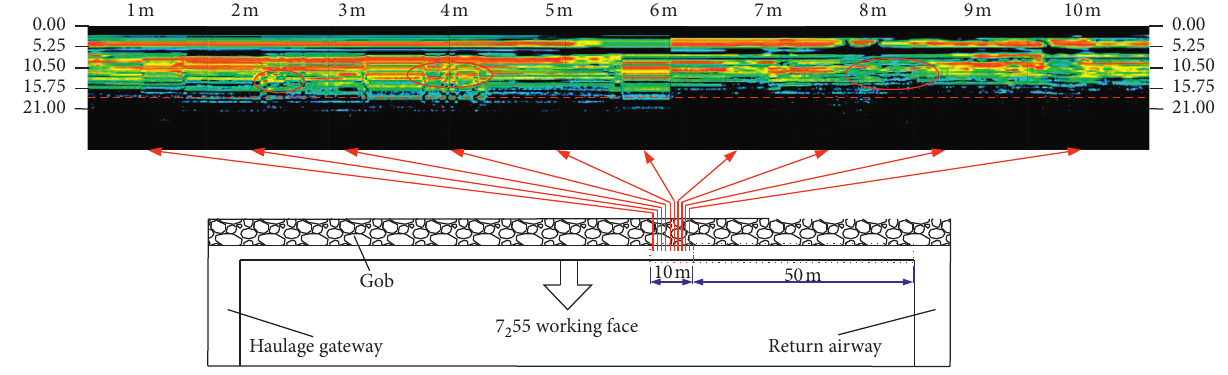
Figure 7: GPR detection results in the working face.